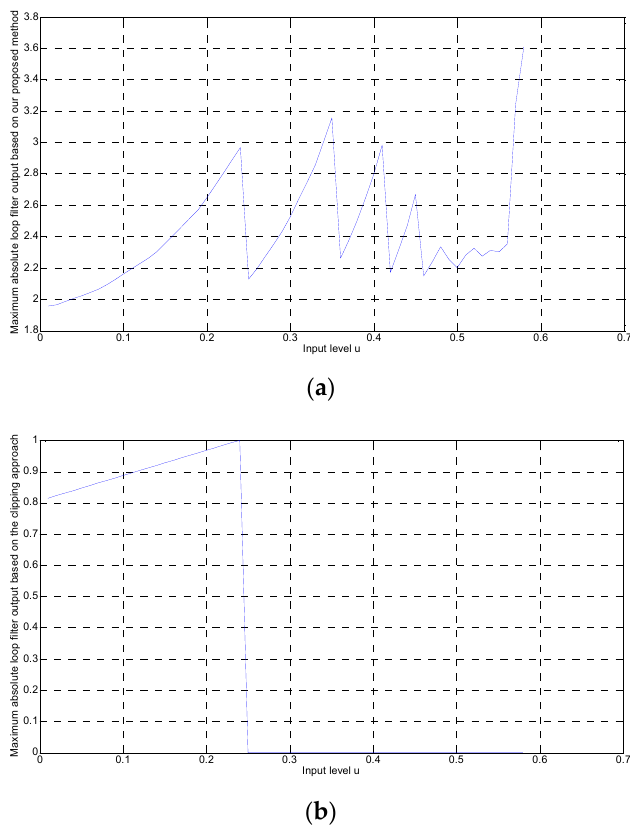
Figure 5. ( a ) The maximum absolute value of the output of the loop filter against the input step size under our proposed control strategy. ( b ) The maximum absolute value of the output of the loop filter against the input step size under the clipping control strategy [7].